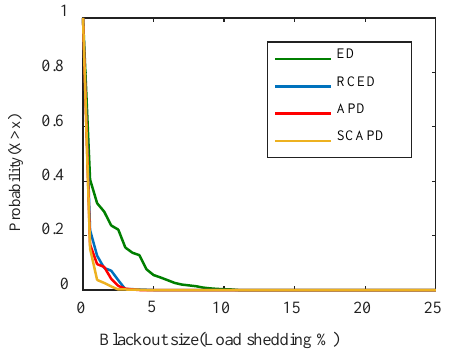
Figure 5. Probability distribution curves of blackout sizes for different models tested on the IEEE 118-bus system. Table 7. Pre-contingency and post-contingency power flow distribution indices and cascade blackout simulation results for different models tested on the IEEE 118-bus system. Models Cost ($) Ave.